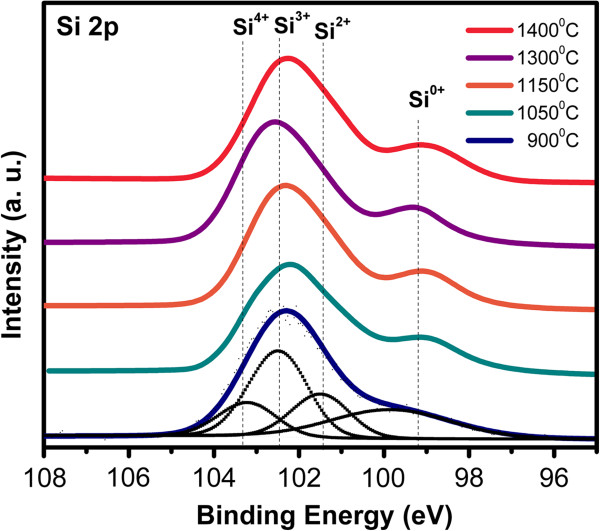
Si 2p XPS spectra show the composition of the SiOxfilms.